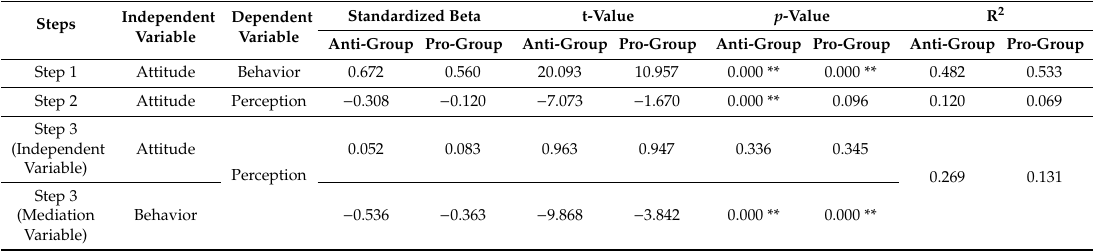
Table 8. Low-involvement models for the anti-group and the pro-group.